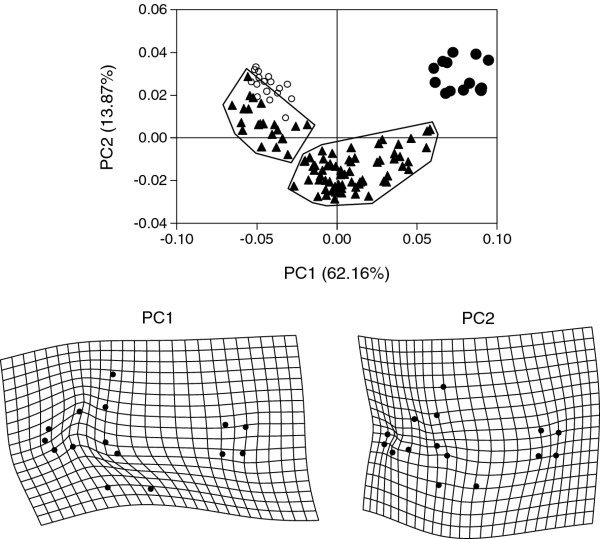
Principal components analysis illustrating the ontogenetic trajectory of
 Acanthurus triostegus 
in the shape space. Plots of the first two PCs; percentage of shape variance summarized by each PC is given in parentheses. (○) Larvae at settlement, (▲) Juvenile and (●) adult specimens. The polygons illustrate the visual discrimination of two groups in juveniles. TPS-grids illustrate shape changes associated with the first two principal components. PC1-grid and PC2-grid span across a total of 0.1 axis unit (−0.05 to 0.05) and 0.06 axis unit (−0.03 to 0.03), respectively. The shape differences have been exaggerated for better visualization (PC1: x1.5; PC2: x2.5).